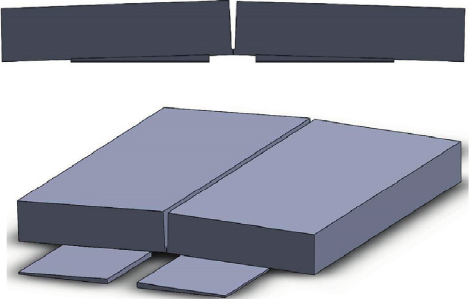
Figure 1: Shape of welding groove. Table 1: Chemical compositions of base metal and filler metal.